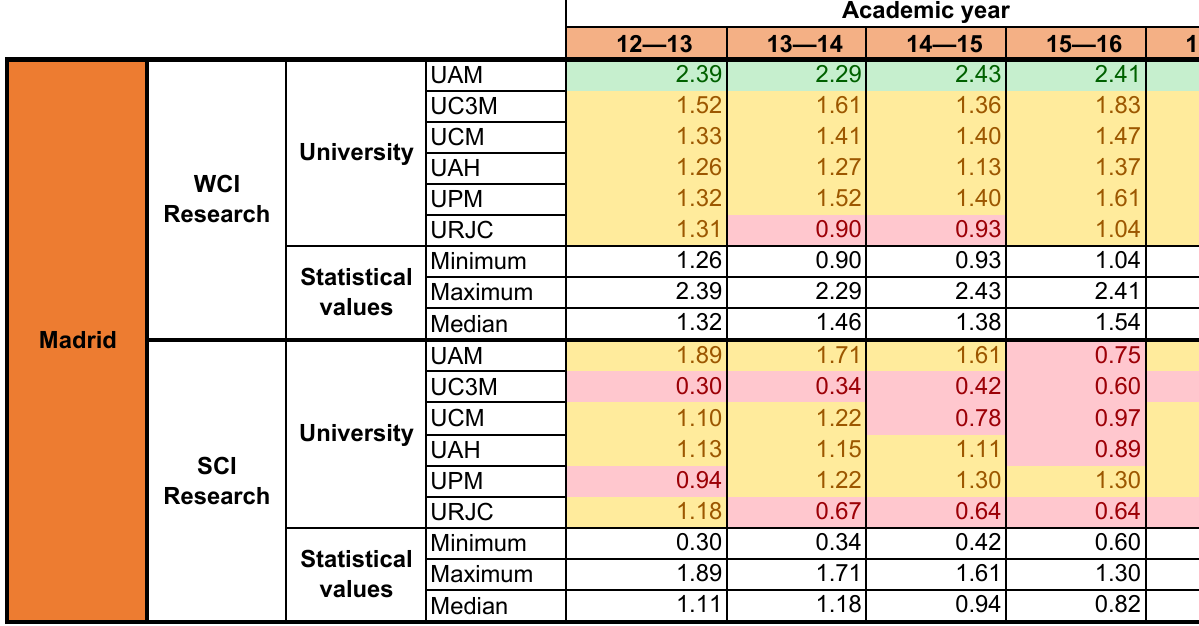
Figure A11. WCI and SCI values of the Madrid public universities in their research